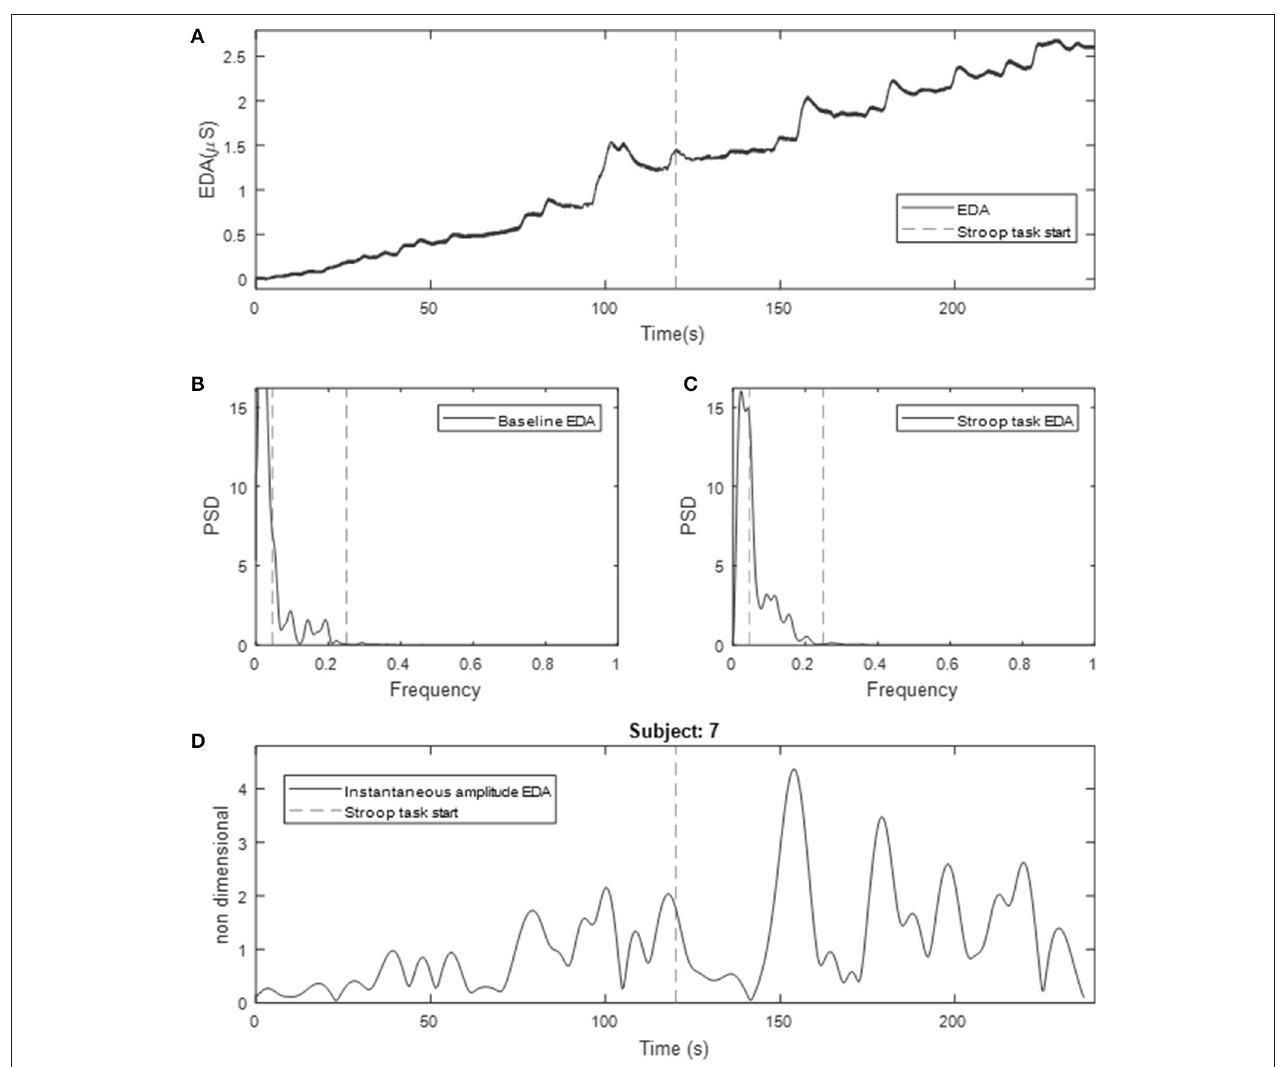
FIGURE 2 | Obtained EDA for a given subject undergoing Stroop test underwater. (A) Raw EDA data, (B) spectrum of baseline measurement; (C) spectrum of Stroop test measurement (dotted lines represent 0.05Hz and 0.25Hz); (D) instantaneous amplitude computed using time-varying spectral analysis (line represents the time when Stroop task starts). Values are expressed as mean ± standard